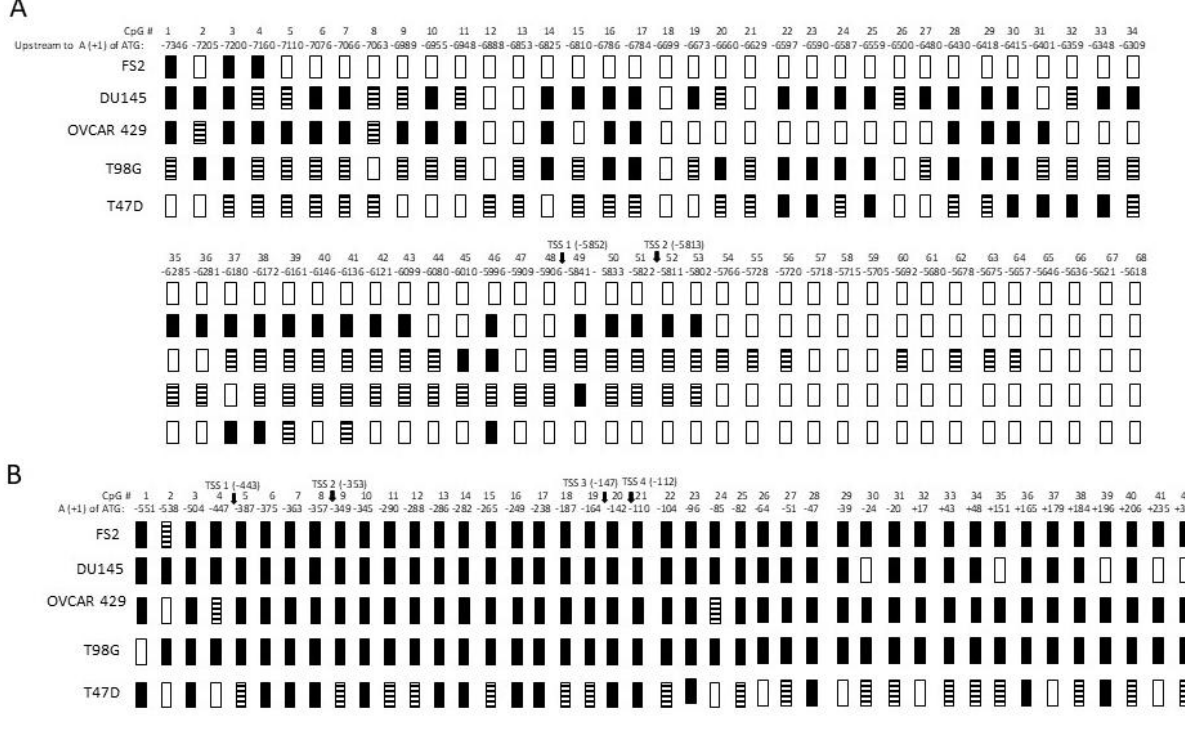
Figure 6. Methylation map of promoters P NN panel ( A ) and P N panel ( B ) in normal fibroblast cells (FS2) and four cancer cell lines (DU145, OVCAR429, T98G, T47D). Transcription start sites are indicated. Open rectangles denote unmethylated CpG, solid rectangles denote completely methylated CpG, and striped rectangles indicate methylated and some unmethylated clones. CpG sites 69 – 90 of P NN promoter are not shown as all of them were unmethylated.